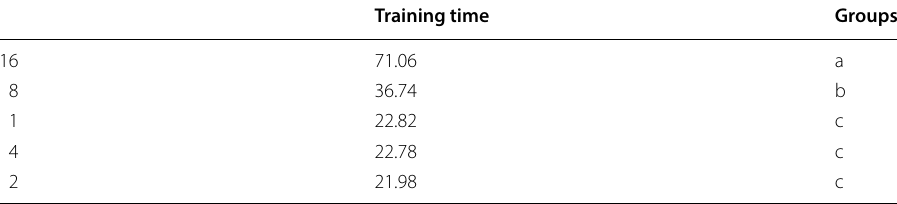
The slowest is the 16 node cluster, second slowest is the 8 node cluster, and all clusters in group “C” have no difference in training time Training time vs. # nodes,